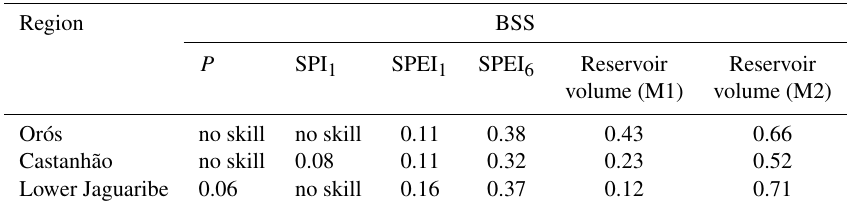
Table 2. BSS of January–May multi-model ensemble forecast. The ensemble includes ECHAM and the ECMWF seasonal forecast model, as well as the EQM and XDS downscaling techniques. The BSSs are averaged over each region. Columns show different indices used for the forecast: P is seasonal precipitation, SPI 1 and SPEI 1 are standardized precipitation indices with scale 1 month, and Reservoir volume stands for regional reservoir volume in percentage of regional storage capacity. The BSS refers to meteorological and hydrological drought events described in Sect.